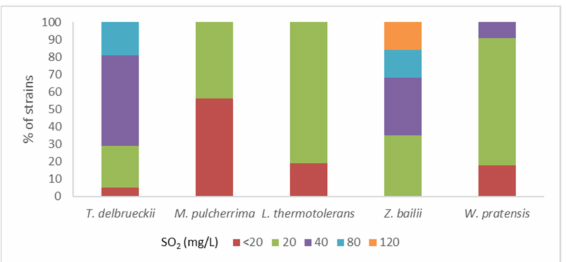
Figure 1. Distribution of strains within each species according to the maximum level of SO 2 which allowed a strain growth similar to control at 24 h